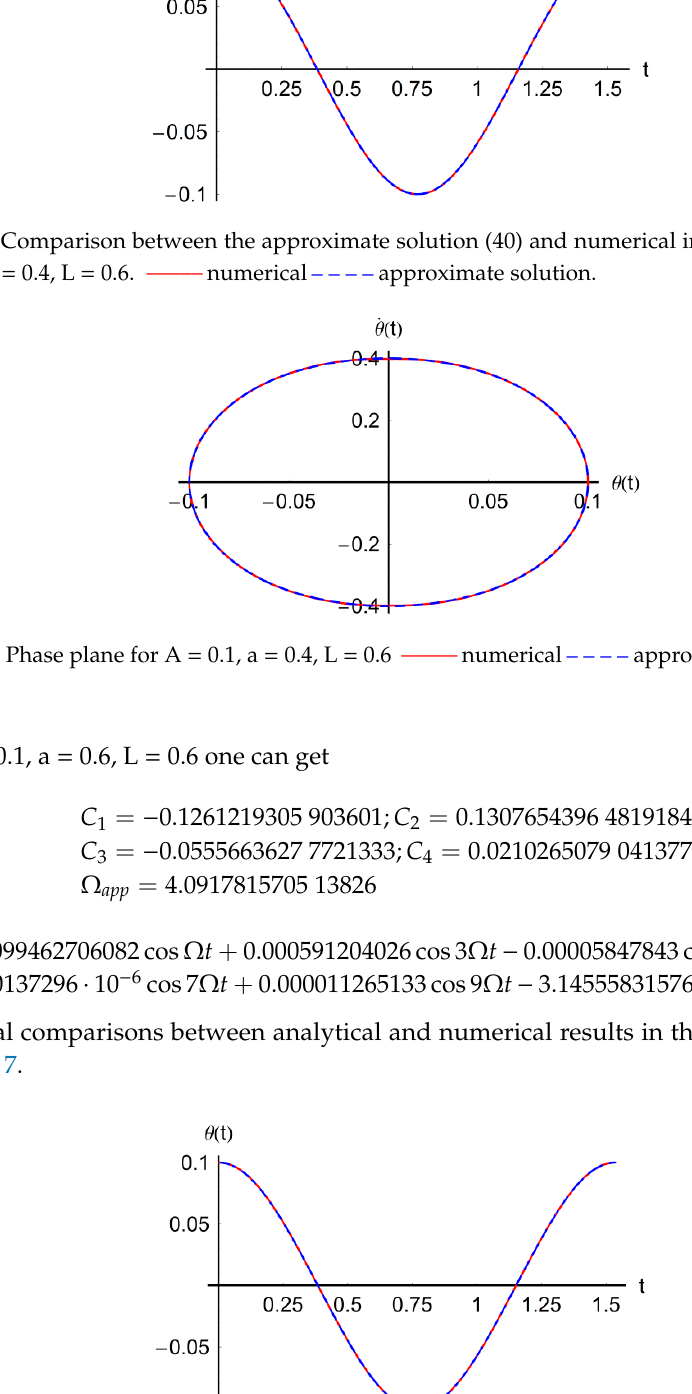
Figure 21. Phase plane for A = 0.4, L = 0.6. Figure 6. Comparison between the approximate solution (41) and numerical integration results for A = 0.1, a = 0.6, L = 0.6.